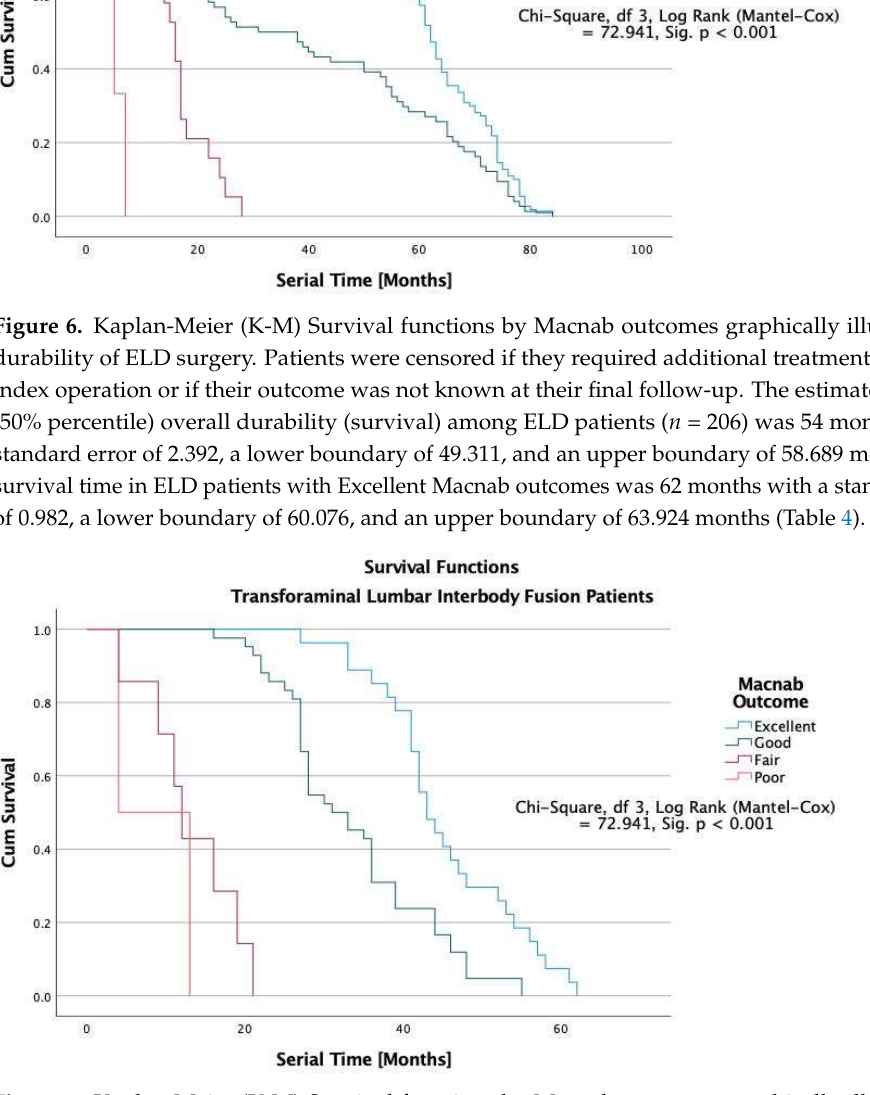
Figure 7. Kaplan-Meier (K-M) Survival functions by Macnab outcomes graphically illustrate the durability of laminectomy surgery. Patients were censored if they required additional treatment after their index operation or if their outcome was not known at their final follow-up. The estimated median (50% percentile) overall durability (survival) among laminectomy patients ( n = 61) was 29 months with a standard error of 1.672, a lower boundary of 25.724, and an upper boundary of 32.276 months. The estimated median survival time in laminectomy patients with Excellent Macnab outcomes was 31 months with a standard error of 3.595, a lower boundary of 23.954, and an upper boundary of 38.046 months (Table 4).